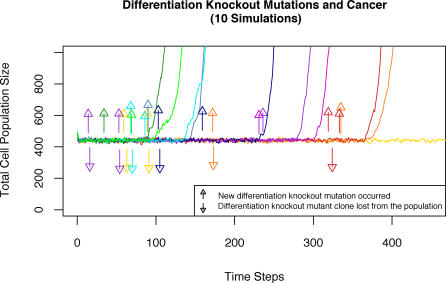
Cell Population Size in Response to Stochastic Occurrence of Differentiation Knockout MutationsThe total population size for more than 400 simulation timesteps is pictured here for ten different runs in different colors. Color-matched arrows indicate when a new differentiation knockout mutation occurred and when the resulting mutant clone went to extinction. Note that the new differentiation knockout mutations (if not lost from the population) develop into cancer with a lag time of between 70 and 150 timesteps. The stochasticity of the process is illustrated in one run (in yellow) that never progressed to cancer even though it acquired and lost several differentiation knockout mutations. In each run, homeostasis of cell numbers can be seen up until the appearance of a differentiation knockout mutation.